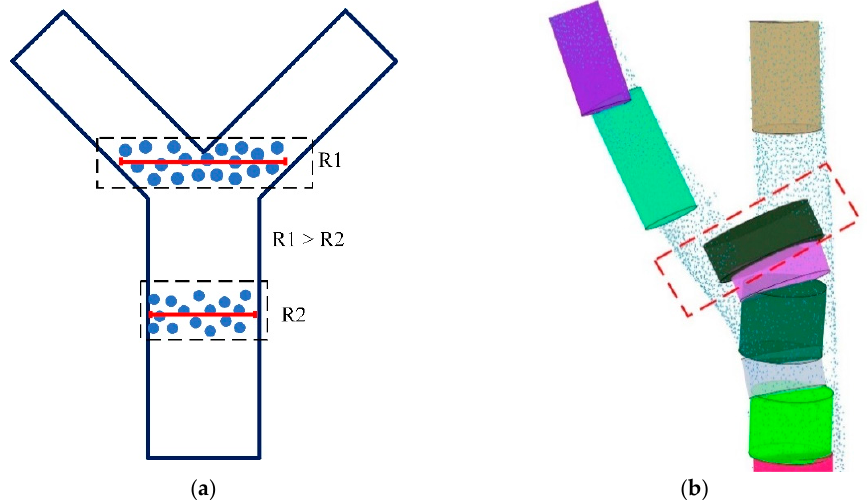
Figure 8. Abnormal fitting for local object primitive. ( a ) Local abnormal fitted diameter; ( b ) abnormal fitted cylinder. In ( a ), it can be found that R1 is obvious larger than R2. The red frame represents the abnormal cylinder.